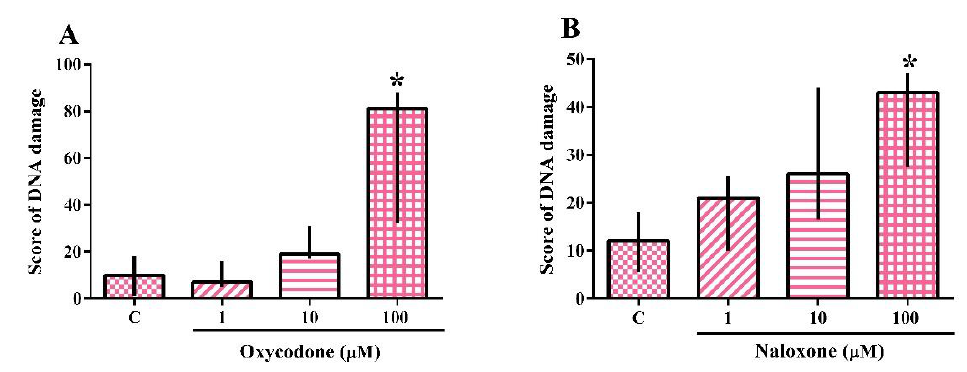
Figure 3. Genotoxicity analysis of a neuroblastoma cell line (SH-SY5Y) exposed for 24 h to oxycodone ( A ) and naloxone ( B ). The results were analyzed by the Kruskal–Wallis test followed by Dunn’s post-test and presented as median ± interquartile interval ( n = 3–5). C: control, nonexposed cells. * Statistically different from C.